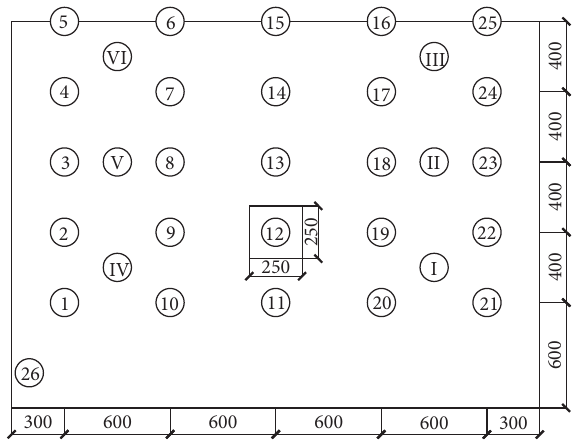
Figure 4: Assignment of sensors and